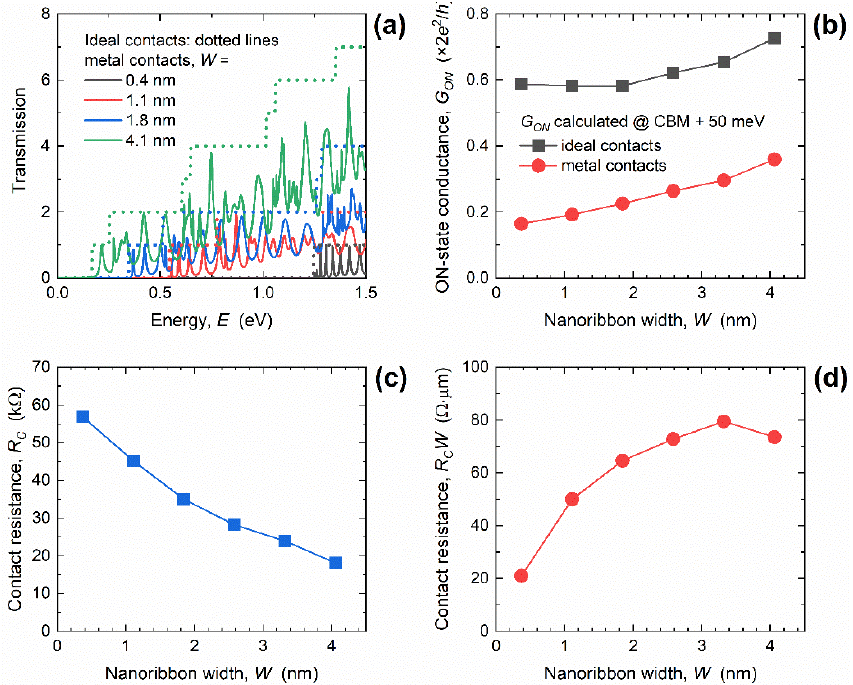
Figure 3. ( a ) Width-dependent transmission in GNRs with ICs and MCs. Impact of GNR width downscaling on ( b ) ON-state conductance, ( c ) contact resistance, and ( d ) width-normalized contact resistance. In all cases, L = 15.2 nm.